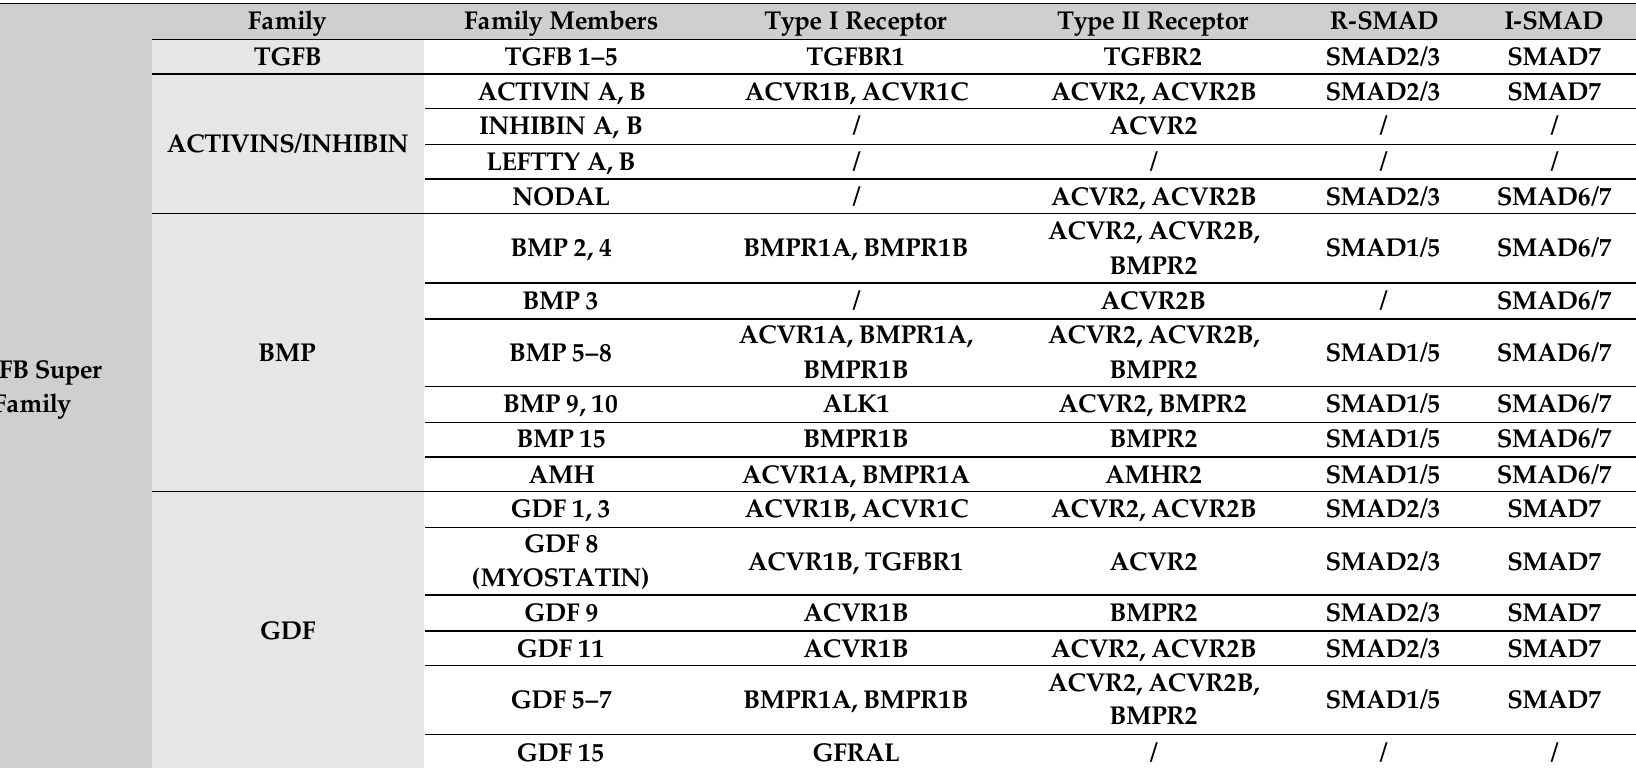
Table 1. Transforming growth factor beta (TGFB) family members, their receptors, and SMAD signaling proteins.